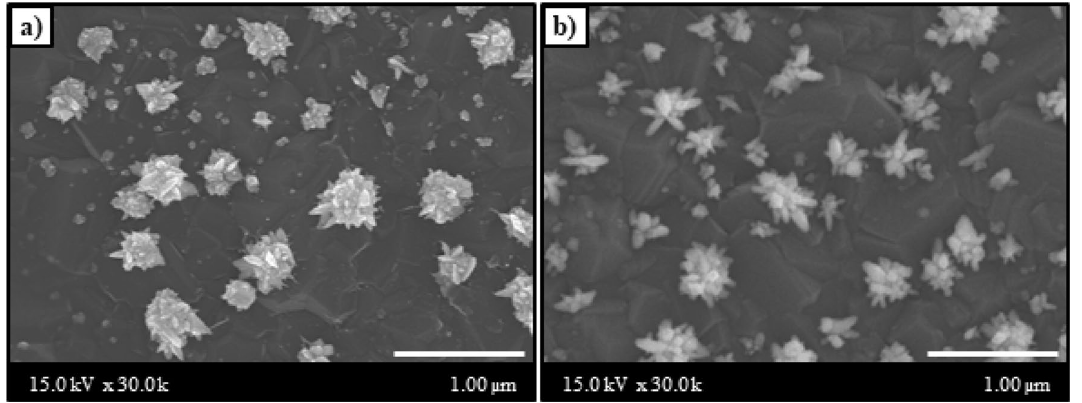
Figure 3. SEM images of Pt/BDD electrode fabricated by ( a ) one-step and ( b ) multiple-step electrodepositions.